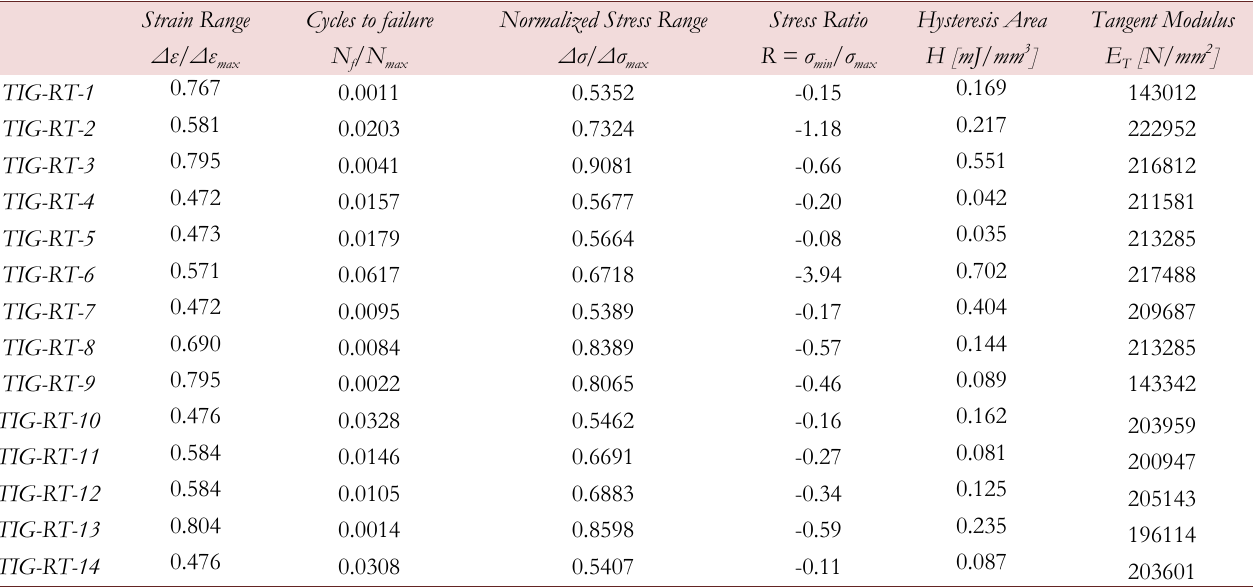
Table 4: TIG Welded Material – Room Temperature: fatigue test results.